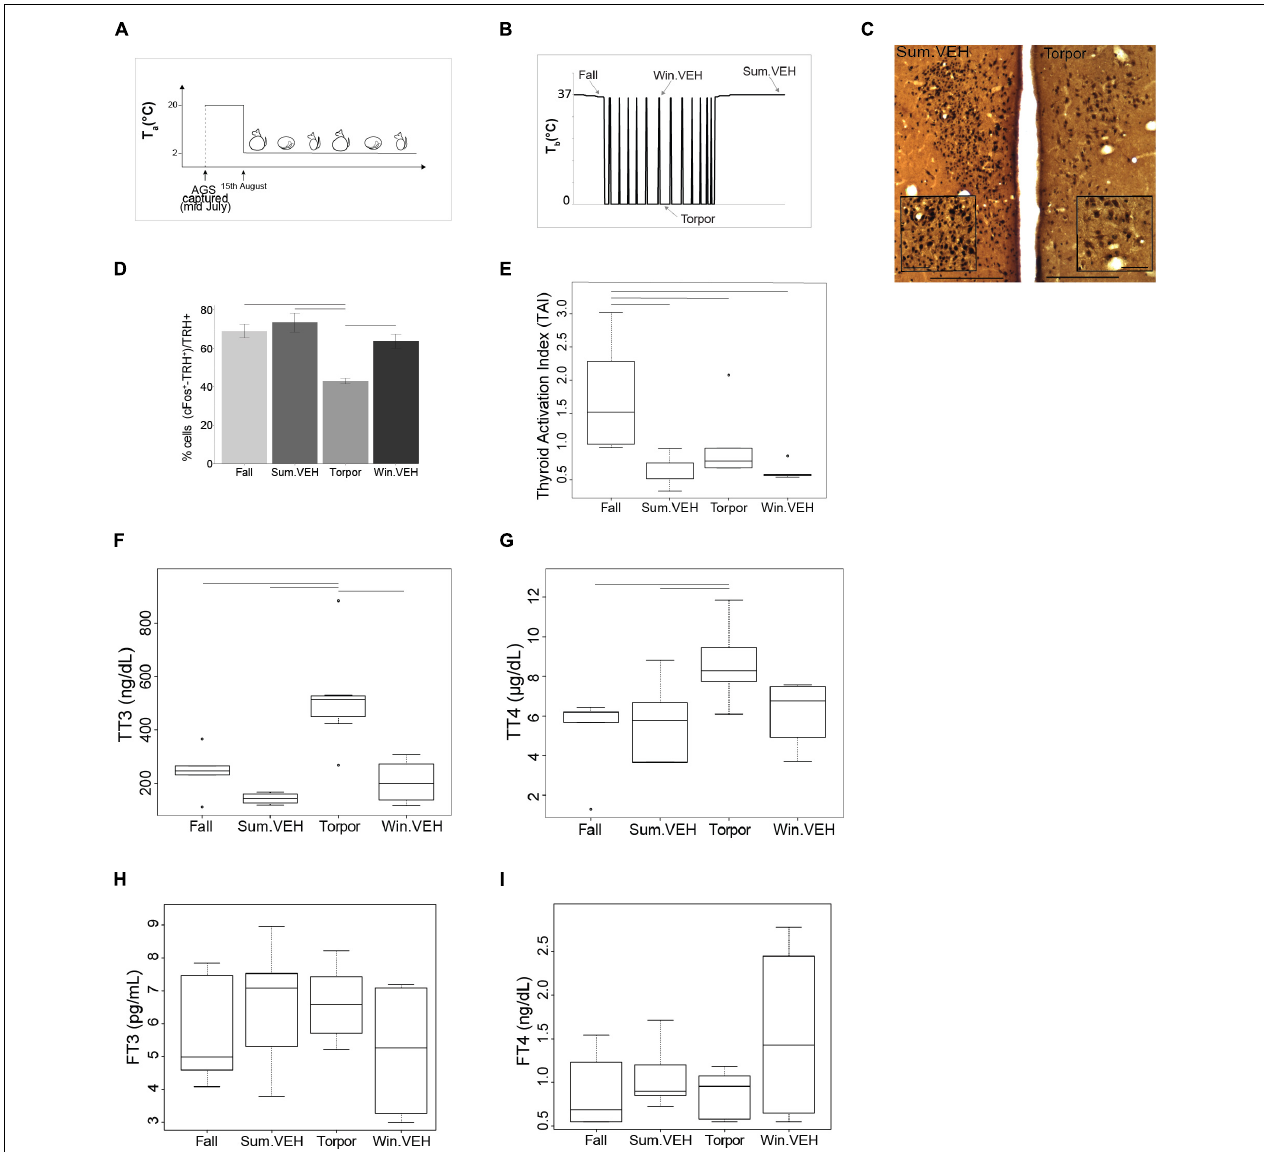
FIGURE 1 | HPT-axis is active in summer and winter euthermia, but not in torpor. All AGS in the study were maintained under the constant environmental conditions (4L:20D and T a = 2 ◦ C) after capture as shown in (A) , AGS maintain seasonal rhythm under the set constant environmental conditions. Results from samples collected at times shown in (B) , illustrate that TRH activation in the PVN is lower in Torpor (D) . Photomicrographs of double stained brain sections in (C) , TRH neurons (brown) and cFos (black) in the PVN are shown in Sum.VEH, as representative of the higher activation group, and in torpor; the insert in PVN images show higher magnification area, scale bar 200 µ m (lower magnification), scale bar 50 µ m (higher magnification). Thyroid activity is significantly higher during the Fall (E) and concentration of TT3 and TT4 is higher in Torpor (F,G) . No changes have been detected in FT3 or FT4 (H,I) . Symbols in (E–G) represent outliers. Horizontal bars represent differences between groups, p < 0.05, t -test in (D,G) and Wilcoxon’s rank-sum test in (E,F) , n = 4–7.